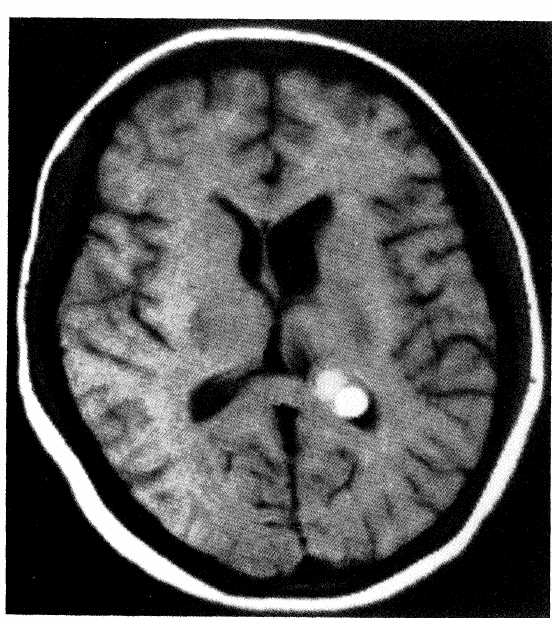
Fig. 2. MRI scan of the head following ventriculostomy. An axial T weighted image through the ventricles demonstrates the high signal intensity cysticercus cyst within the trigone region of the left lateral ventricle. There is disproportionate enlargement of the left lateral ventricle, but the right lateral and third ventricles are normal in